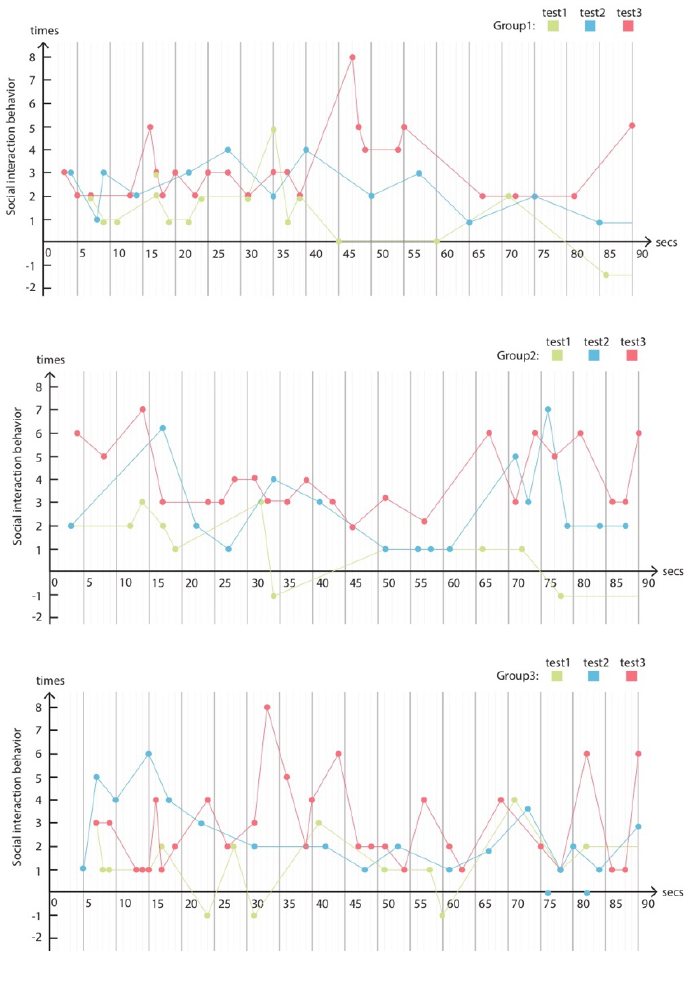
Figure 4. Analytic graph for the three testing